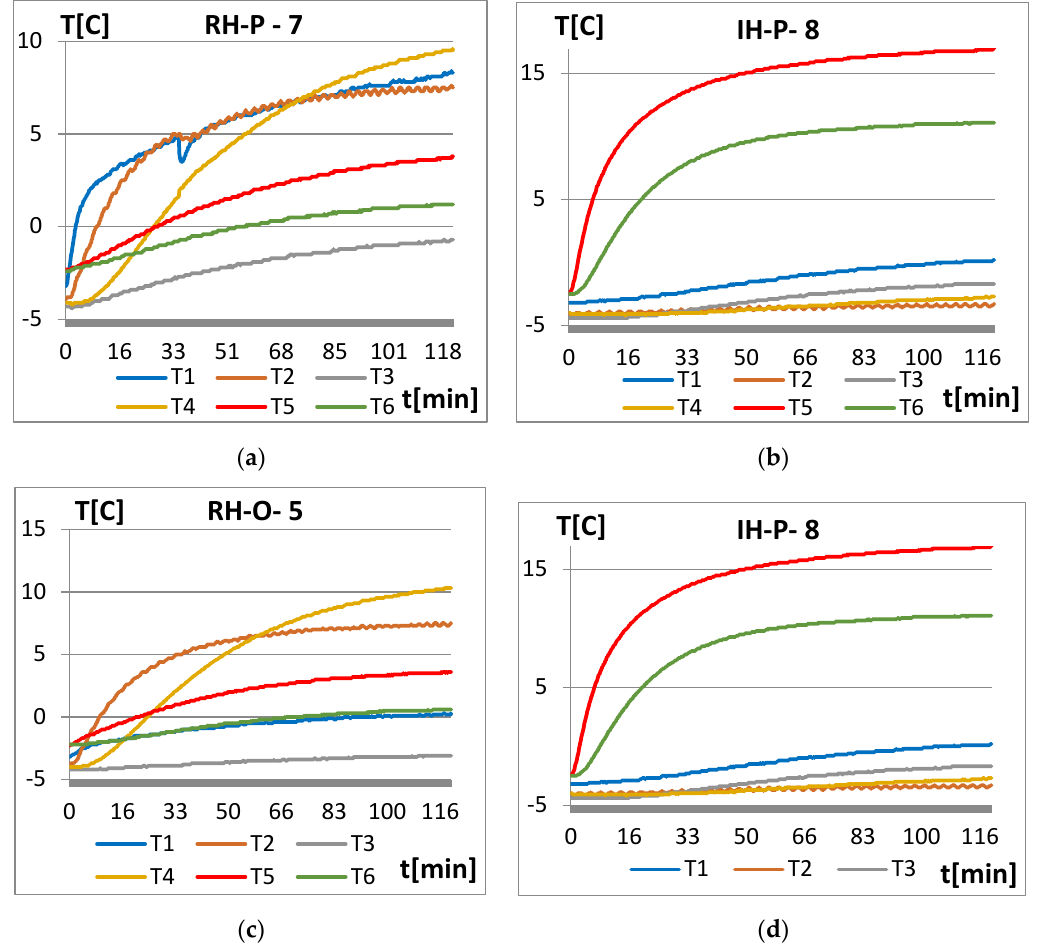
Figure 19. Temperature distribution across a turnout for ambient temperature − 5 °C for the slide plate at the points: T1 — on the switch-rail foot, T2 — on the stock-rail foot, T3 — on the switch-rail head, T4 — on the stock-rail head, T5in the slide plate part to the side of the stock-rail, T6 — in the slide plate part to the side of the switch-rail; ( a ) resistance heating, the switch-rail touching; ( b ) induction heating, the switch-rail touching; ( c ) resistance heating, the switch-rail away; and ( d ) induction heating, the switch-rail away.